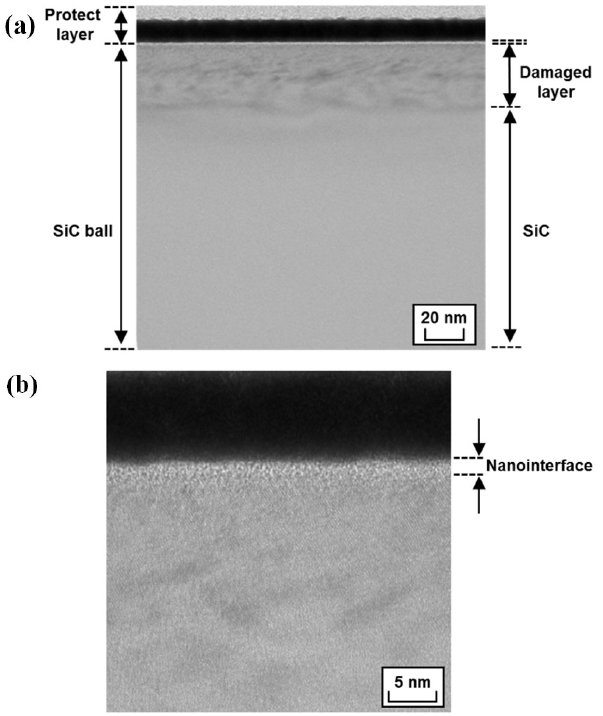
Fig. 5 Cross-sectional TEM images of top wear surface of SiC ball with (a) global vision and (b) magnified visions around nanointerface observed after 100-m sliding in 0.001 wt% NDP–OH. Table 2 XPS elemental composition analysis of wear